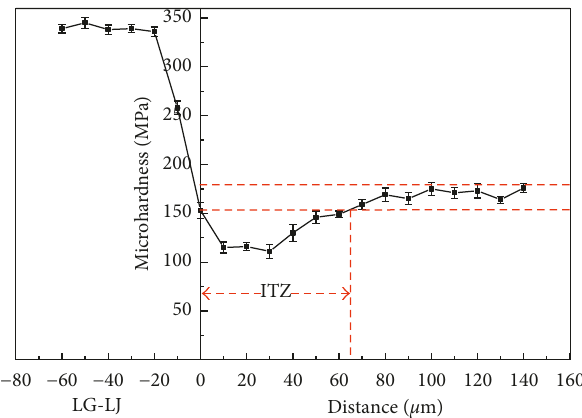
Figure 5: Interface microhardness of the LG-LJ interface.